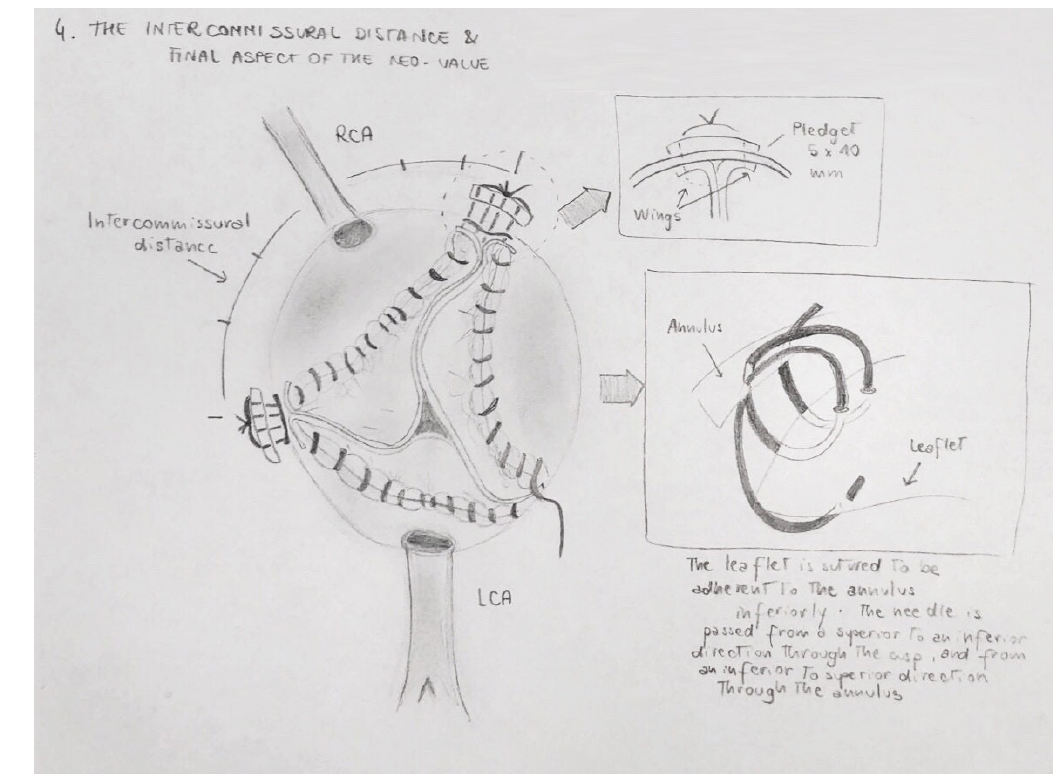
Fig. 4 – Intercommissural distance and final aspect of the neovalve. LCA=left coronary artery; RCA=right coronary